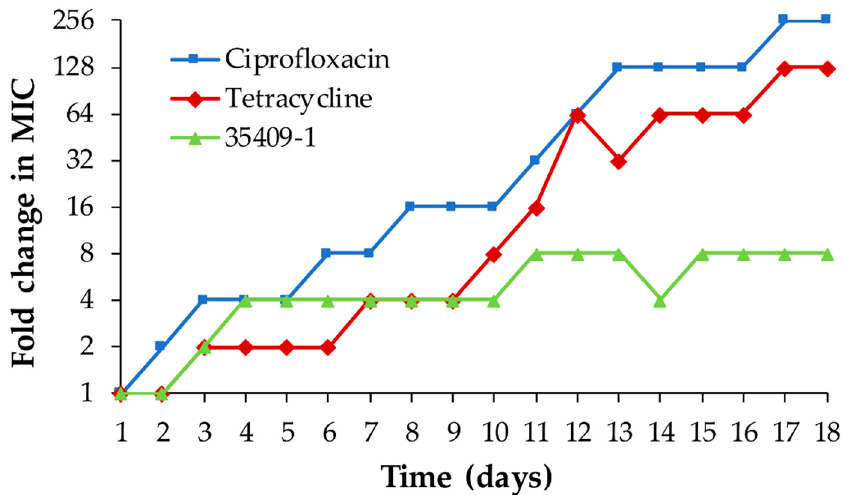
Figure 3. Developing resistance in E. coli ATCC 25922 by 35409-1-treatment. The figure shows MIC variation for bacteria repeatedly treated with 0.5 × MIC for peptide 35409-1 compared to MIC variation for bacteria treated with 0.5 × MIC for ciprofloxacin and tetracycline.